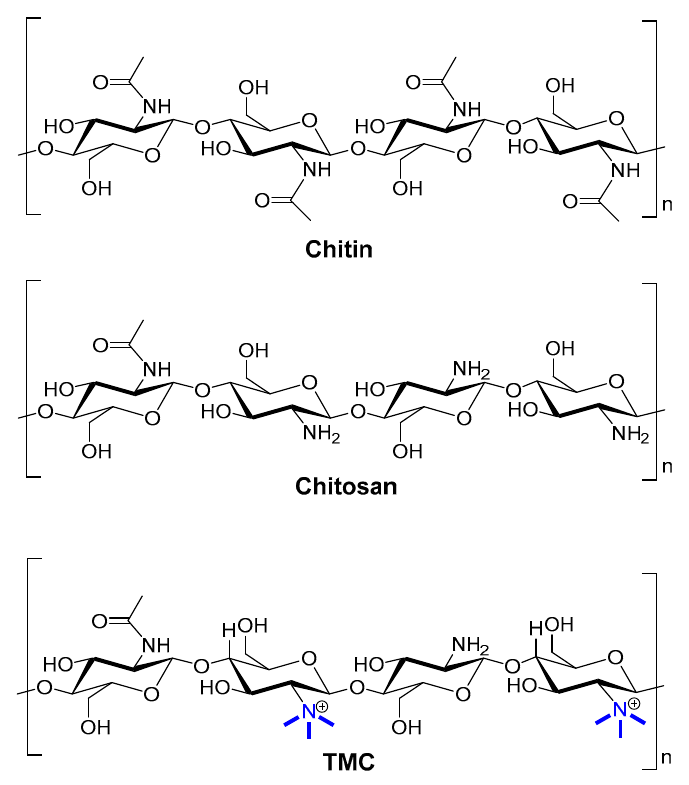
Figure 5. Comparison of the chemical structures of chitin, chitosan, and TMC.